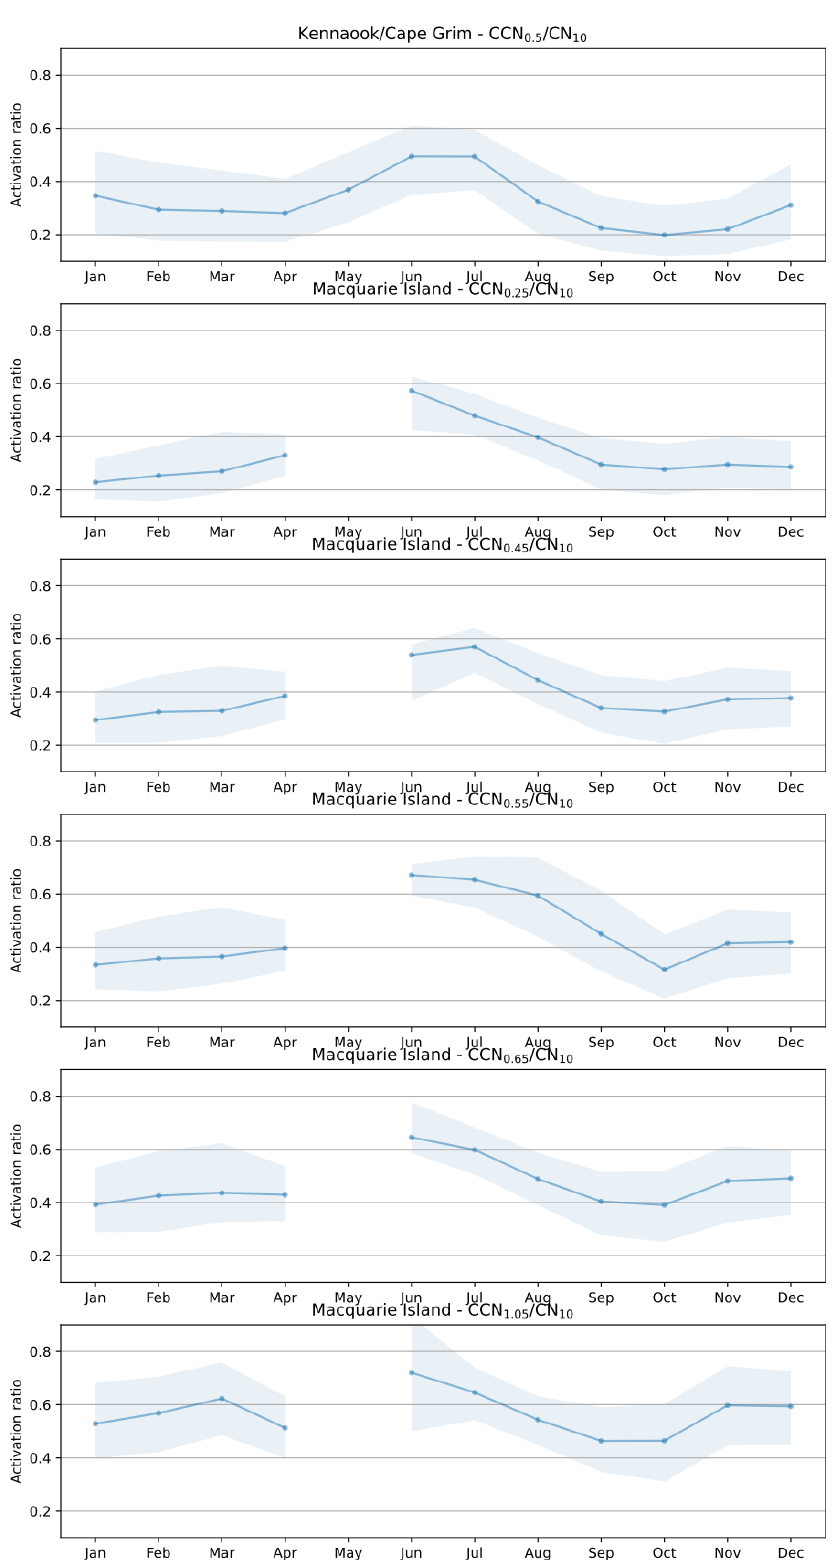
Figure A3. Annual cycles of the CCN activation ratio for Kennaook / Cape Grim (top) and then all observed supersaturations at Macquarie Island. Unfortunately, instrument malfunctions of either the CPC or CCNC resulted in no ratio data available for May and the first half of June at Macquarie